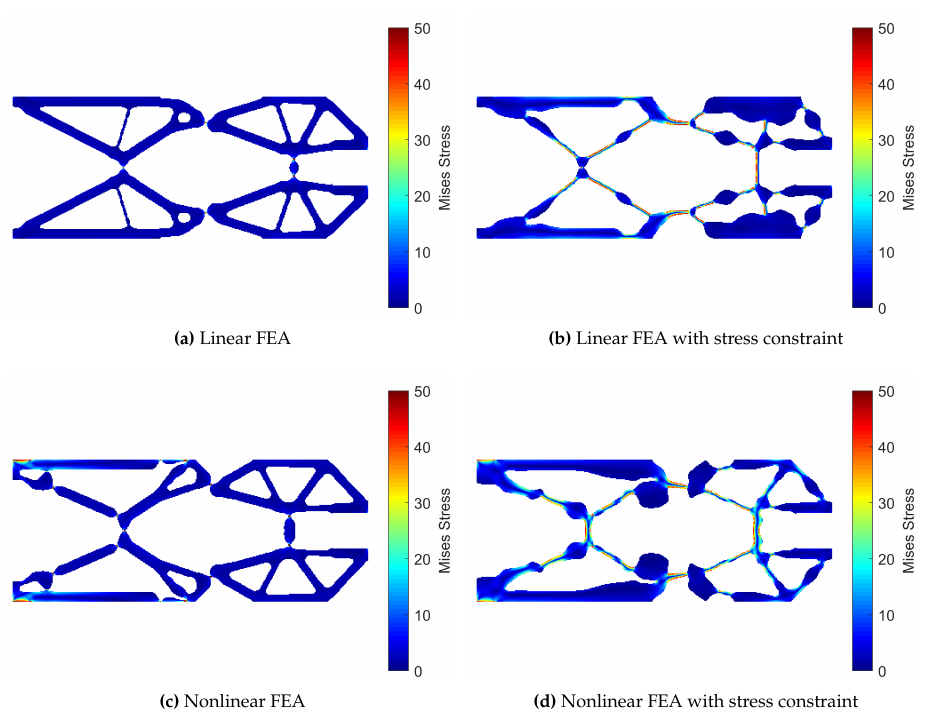
Figure 3. Comparison of topology optimization results for the maximum output displacement gripper example (400 80 elements). ×